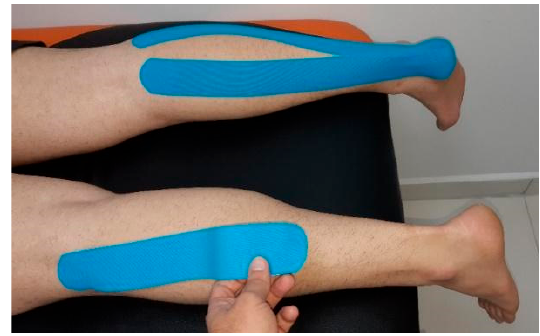
Figure 1. KT application on triceps surae.